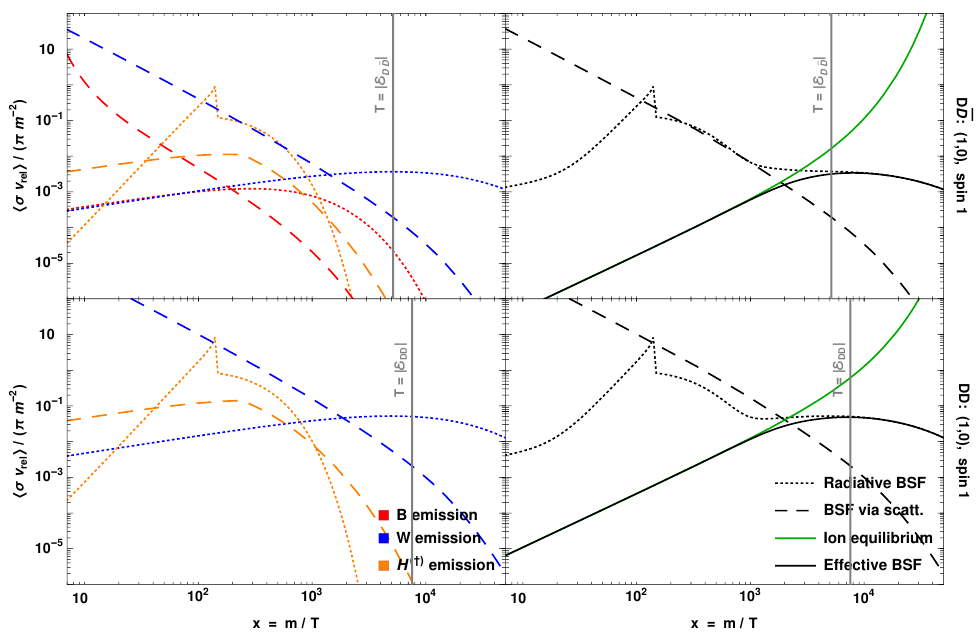
¯ Figure 1 . Thermally averaged BSF cross-sections for the D D and DD bound states; the latter includes the capture into its conjugate. We have used m = 20 TeV , α = 0 . 2 and the temperature H dependent Higgs mass m ( T ) ; the spikes in the radiative BSF occur at the EWPT, when the Higgs H mass tends to zero before becoming m 125 GeV . The vertical lines mark the temperatures h ’ equal to the binding energies. Note that the cross-sections have been regulated according to [35, section